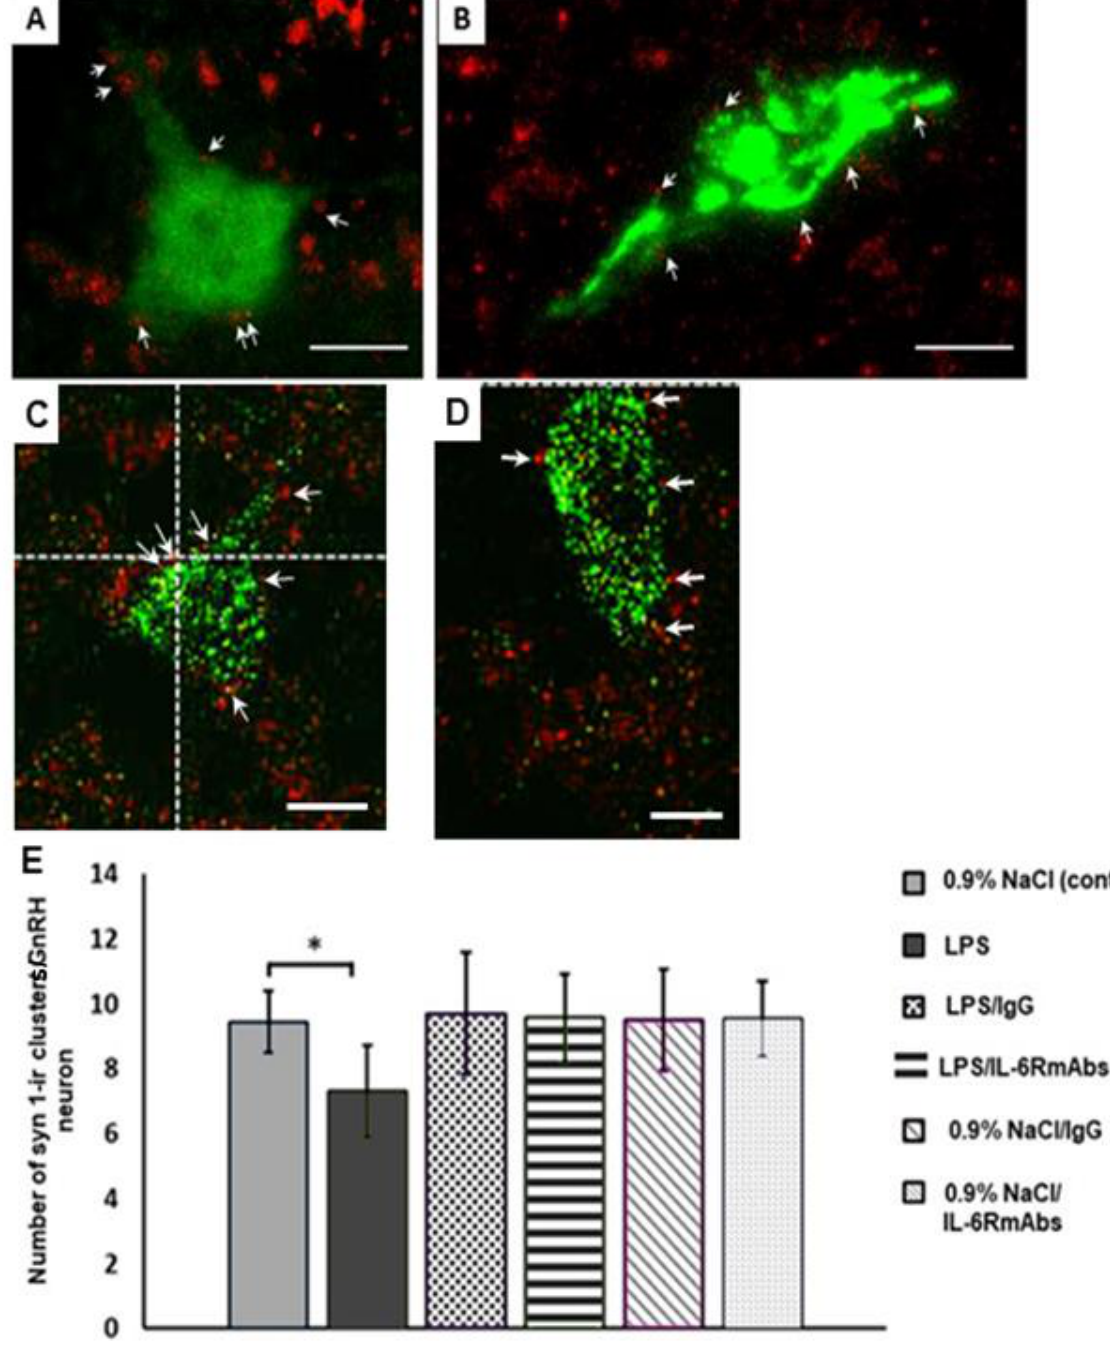
Figure 3. Synapsin-1-immunoreactive (syn 1-ir) clusters on the GnRH neurons of males on PND80 treated on ED12 with ( A ) LPS and IgG, ( B ) LPS and IL-6RmAbs, ( C ) 0.9% NaCl and IgG, and ( D ) 0.9% NaCl and IL-6RmAbs. The maximum projection of confocal microphotograph stacks of neurons stained with anti-GnRH (green) and anti-synapsin-1 (red) antibodies. The white arrows mark the syn 1-ir clusters. Scale bar = 10 μM. ( E ) Number of syn 1-ir clusters in close apposition with the GnRH neurons of males on PND80 treated on ED12 with 0.9% NaCl (control); LPS; LPS and IgG; LPS and IL-6RmAbs; 0.9% NaCl and IgG; and 0.9% NaCl and IL-6RmAbs (n = 10 animals per group). M ± SEM, * p < 0.05, compared with the control